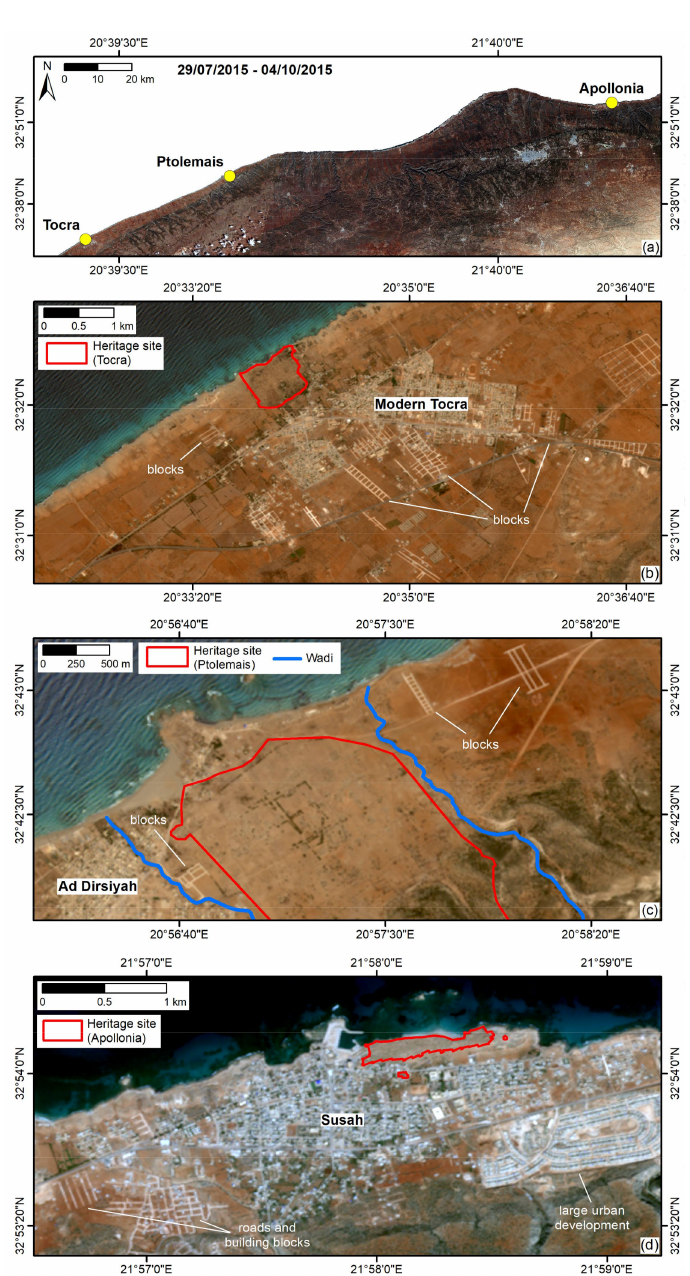
Figure 10. ( a ) Synoptic view of Cyrenaica (Libya) and the archaeological sites of Tocra, Ptolemais, and Apollonia through a multi-temporal mosaic of cloud-free Sentinel-2 images acquired from 29 July 2015 to 4 October 2015. The zoomed views on ( b ) Tocra, ( c ) Ptolemais, and ( d ) Apollonia. Block features and the proximity of the modern towns are clearly visible. Copernicus Sentinel-2 images © 2015 European Space